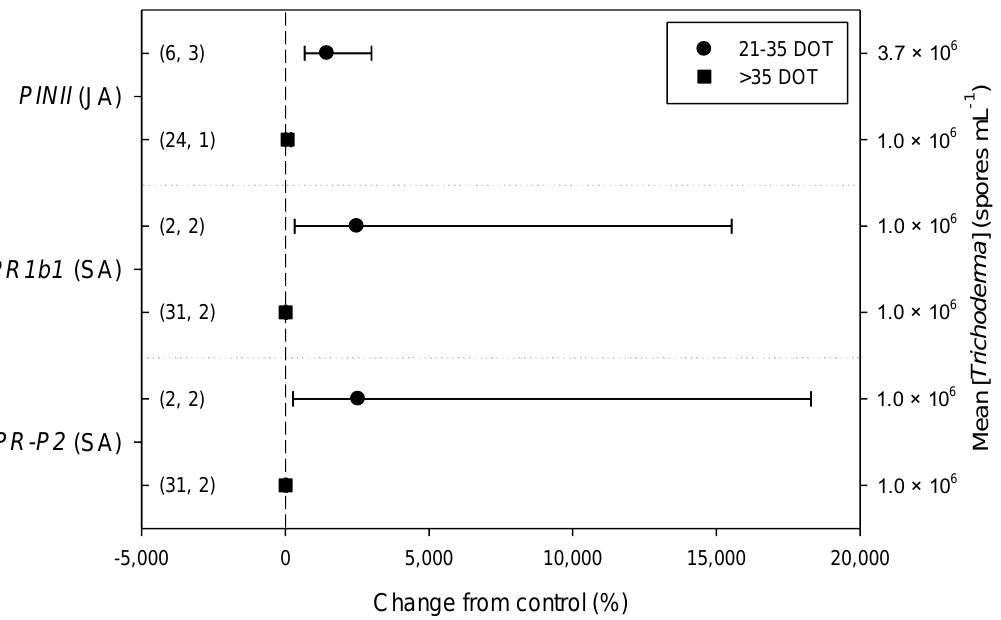
Figure 4. Differential effects of Trichoderma on defense-related genes involved in jasmonic (JA; i.e., proteinase inhibitors II, PINII ) and salicylic acid (SA; pathogenesis-related 1b1 and P2, PR1b1 and PR-P2 ) pathways in tomato leaves infected by Botrytis cinerea on the basis of duration of Trichoderma treatment (21 – 35 and >35 days of treatment, DOT). Symbols represent the mean percentage change due to Trichoderma treatment relative to control (i.e., B. cinerea infection without Trichoderma treatment), and the bars show the 95% confidence interval. Number of observations and papers are shown in parentheses; mean Trichoderma spp. concentrations are given along the right y axis.